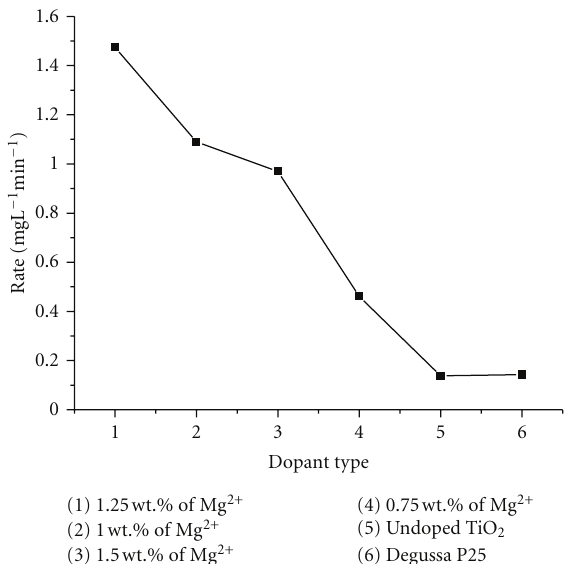
Figure 9: E ff ect of dopant concentration on the degradation of dichlorvos. Catalyst dosage = 0.10 g, pH = 3, and [DDVP] = 150ppm.